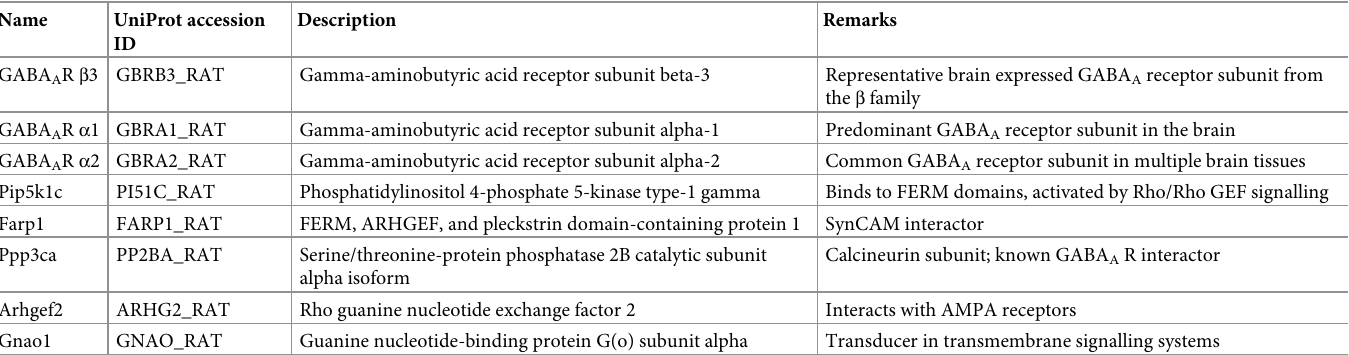
Table 1. Validated novel interaction partners for MPP2 (for co-immunoprecipitation data, see Fig 4 and S6